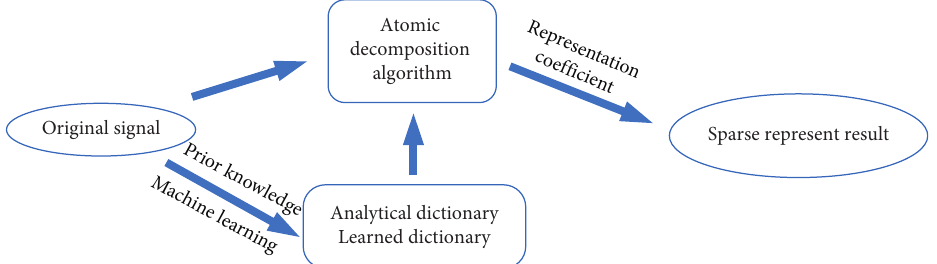
Figure 1: Signal sparse representation process.